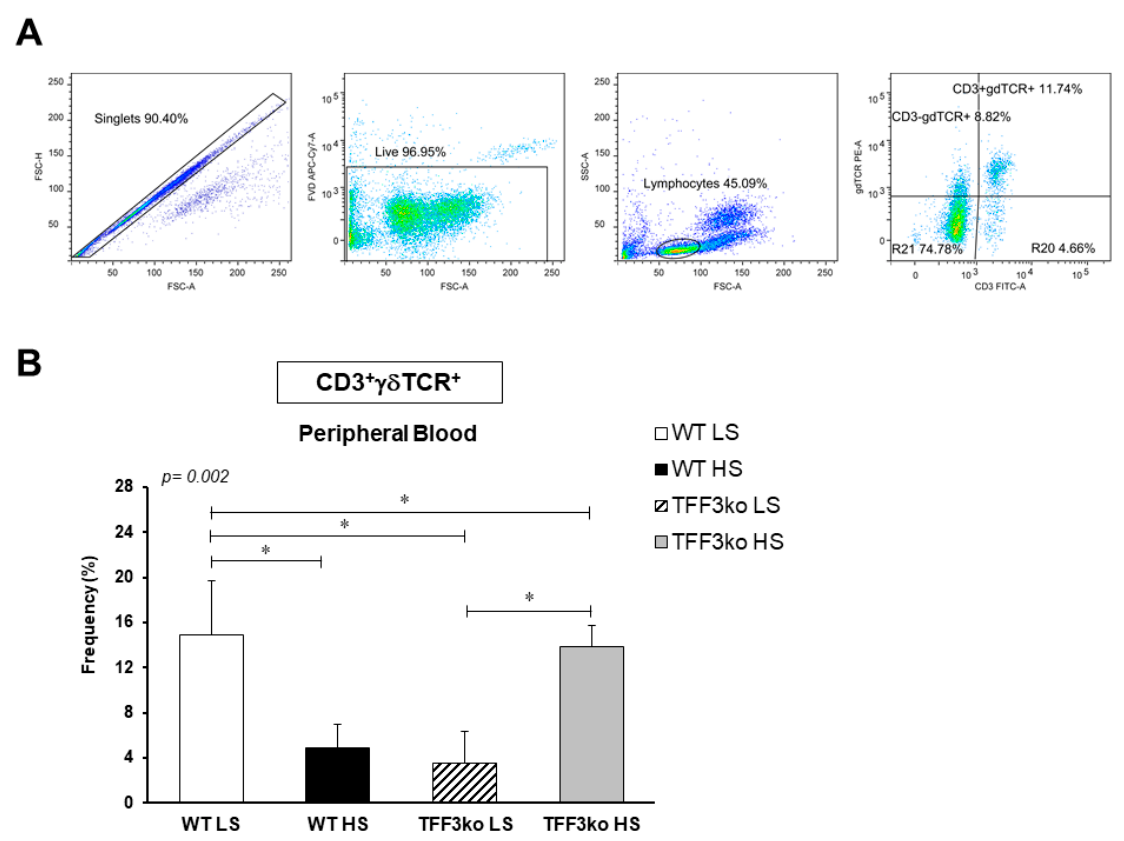
Figure 5. The effect of Tff3 deficiency and a 7-day high-salt (HS) diet on the rates of CD3 T cells expressing gamma delta T-cell receptor in the peripheral blood. ( A ) demonstrates representative gating strategy, including gating on live single cells followed by gating on lymphocytes based on forward and side scatter and further analysis of their CD3 and γδ TCR profiles. ( B ) shows the changing rates of CD3 + γδ TCR + T cells in the study groups following the HS diet. HS—high salt; WT LS—wild-type (C57BL/6N) mice on a low-salt diet; WT LS—wild-type (C57BL/6N) mice on a high-salt diet; TFF3ko LS— Tff3 knock-out mice on a low-salt diet; TFF3ko-HS— Tff3 knock-out mice on a high-salt diet. Data are presented as mean ± SD and were analyzed by one-way ANOVA or Kruskal–Wallis test where appropriate. In some cases, the effect of the diet on a particular strain (TFFko or WT) was tested by Student’s t -test or Mann–Whitney U test; * p -values less or equal 0.05 are considered